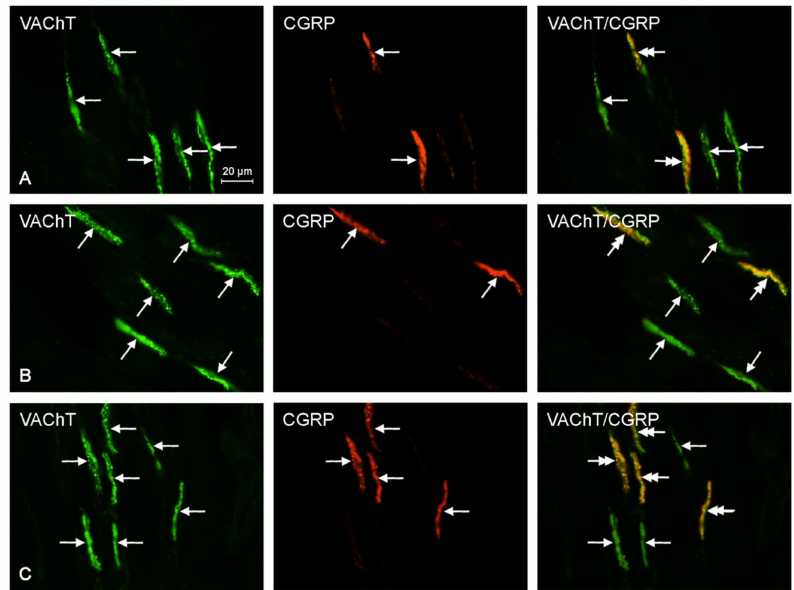
Figure 4. Representative images of immunocytochemical localization of VAChT- and CGRP-immunoreactive nerve fibers in intrahepatic sympathetic nerves (arrows) of the control (CTRL; ( A )), E1—experimental group 1 (low dose of bisphenol A; ( B )), and E2—experimental group 2 (high dose of bisphenol A, ( C )); VAChT or CGRP-IR nerve fibers are indicated with arrows, VAChT and CGRP-IR nerve fibers are indicated with double-headed arrows; scale bars in all figures; 20 µ m.